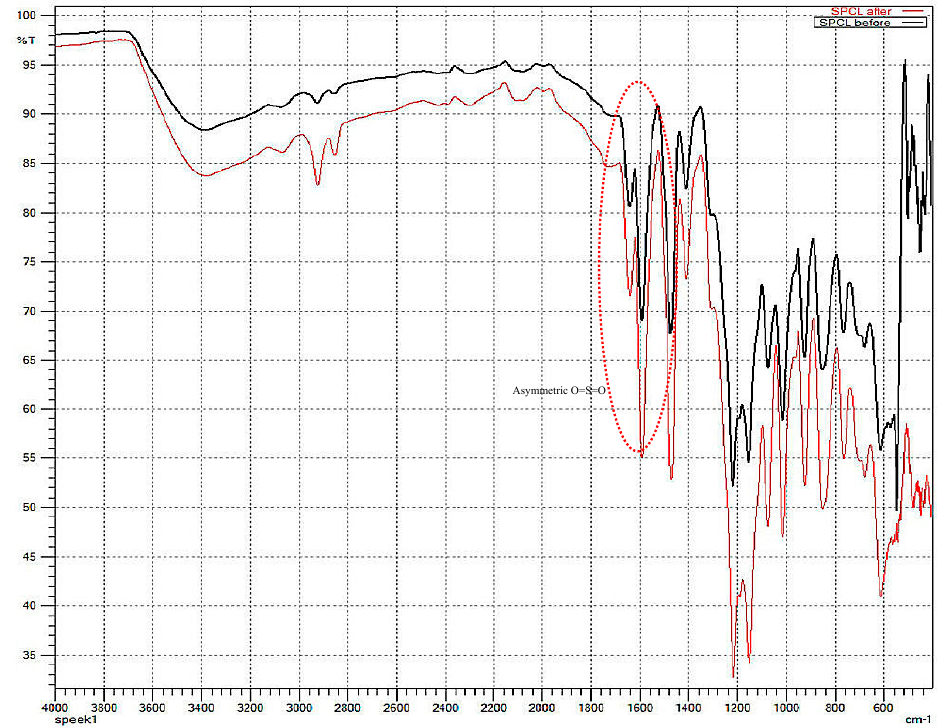
Figure 3. FTIR spectra on casted Sulfonated Poly(Ether Ether Ketone) (SPEEK)/Cloisite membrane and SP/e-spunCL